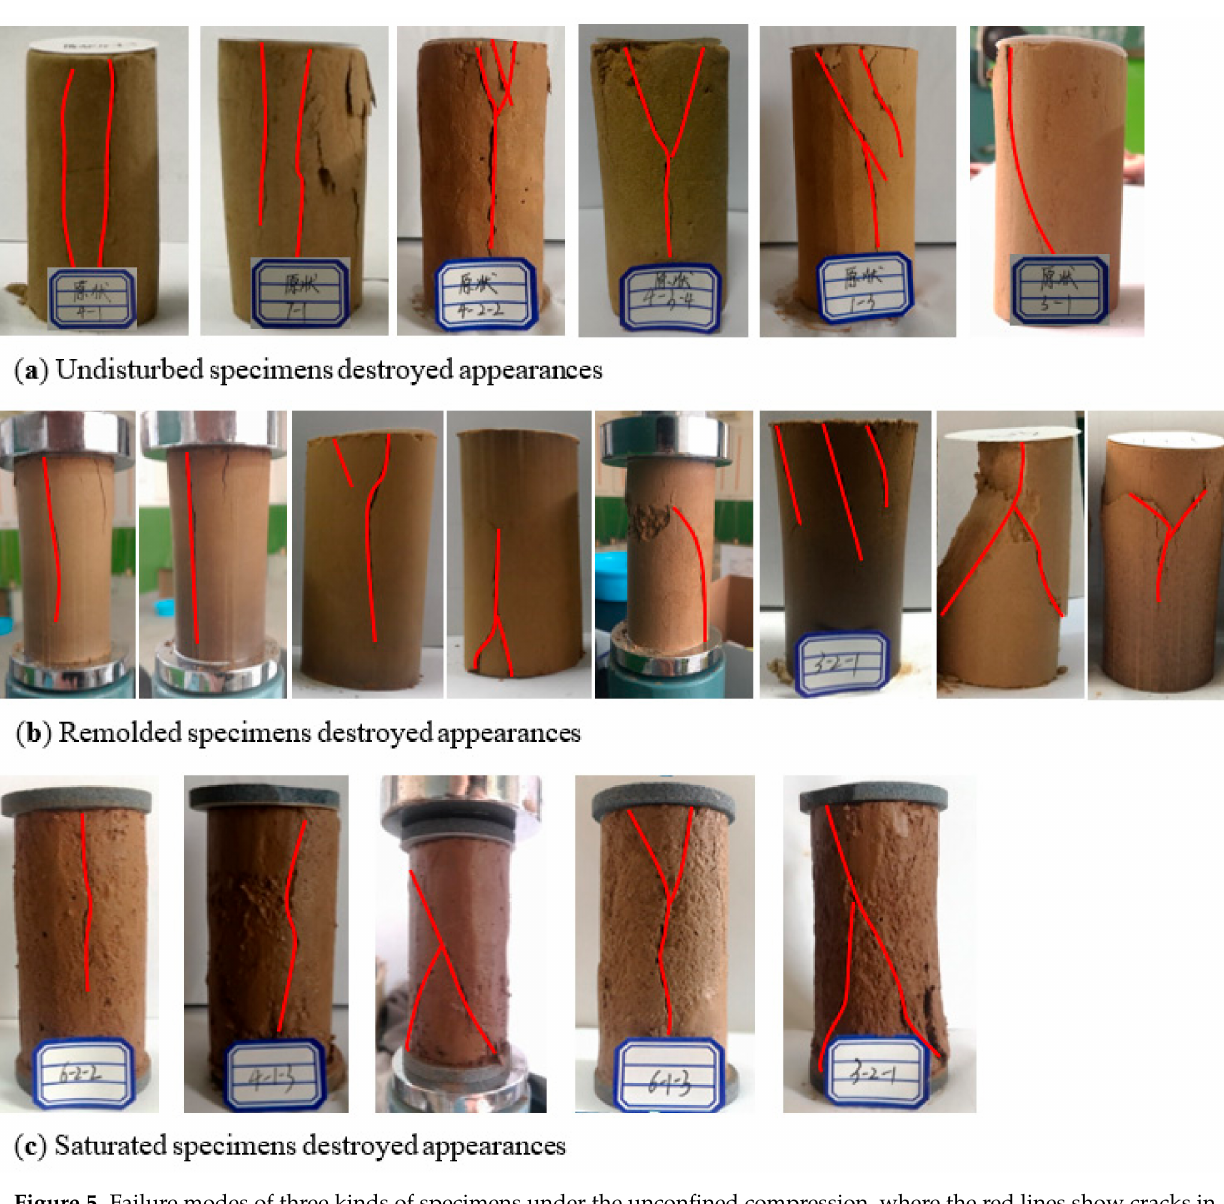
Figure 5. Failure modes of three kinds of specimens under the unconfined compression, where the red lines show cracks in the specimens at the time of failure. ( a ). the number of samples are 4-1, 7-1, 4-2, 4-3, 1-3, 3-1 (from left to right); ( b ). the number of samples are 1-2, 1-2, 3-3, 3-3, 6-3,7-2, 7-3, 7-3 (from left to right); ( c ). the number of samples are 6-2, 4-1, 3-1, 6-1, 3-2 (from left to